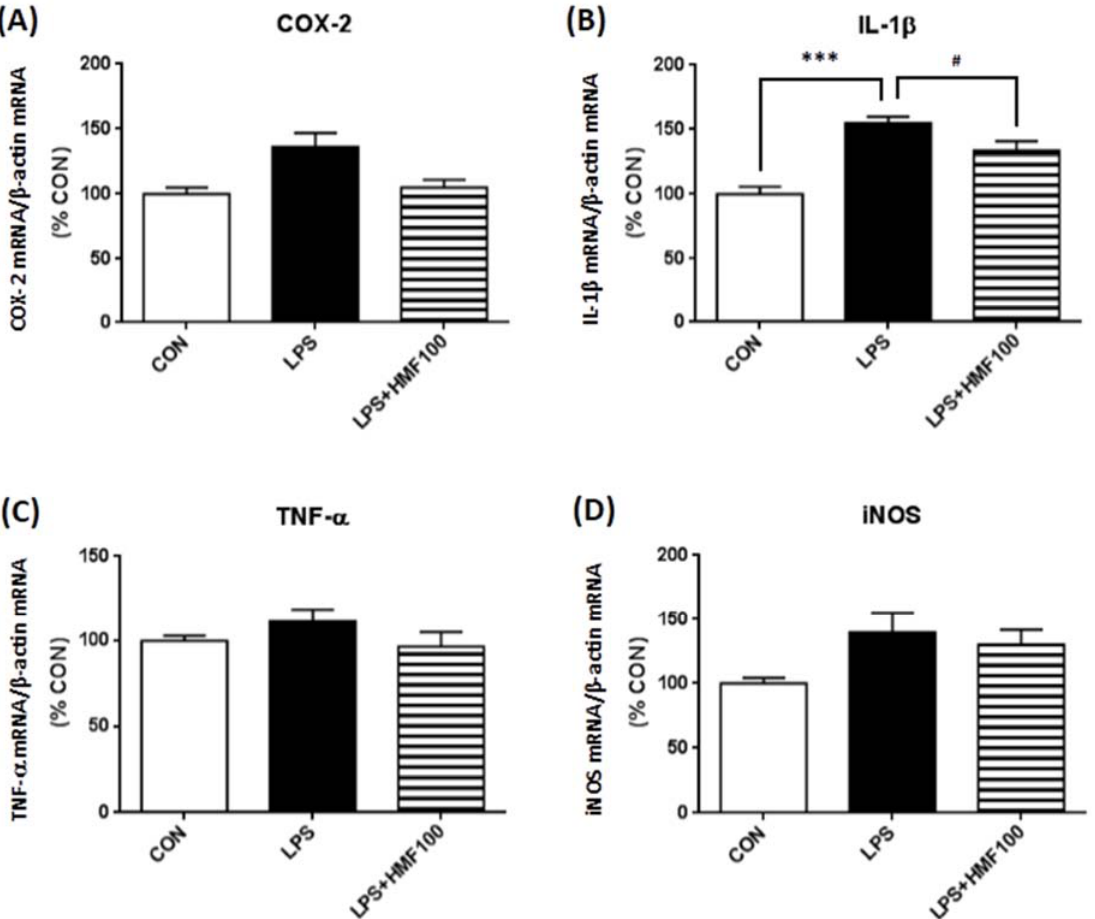
Figure 4. Effects of HMF on the expression of mRNAs for inflammatory markers in the hippocampus. Hippocampal tissues were prepared two days after LPS intrahippocampal injection, and RT-PCR analysis was performed with specific primers. Densitometric quantification of mRNAs of COX-2 ( A ), IL-1 β ( B ), TNF- α ( C ) and iNOS ( D ) band intensities normalized by the β -actin mRNA band in the hippocampus. Values are the means ± SEM. Symbols are significantly different for the following conditions: CON vs . LPS, *** p < 0.001; LPS vs . LPS + HMF100, # p <